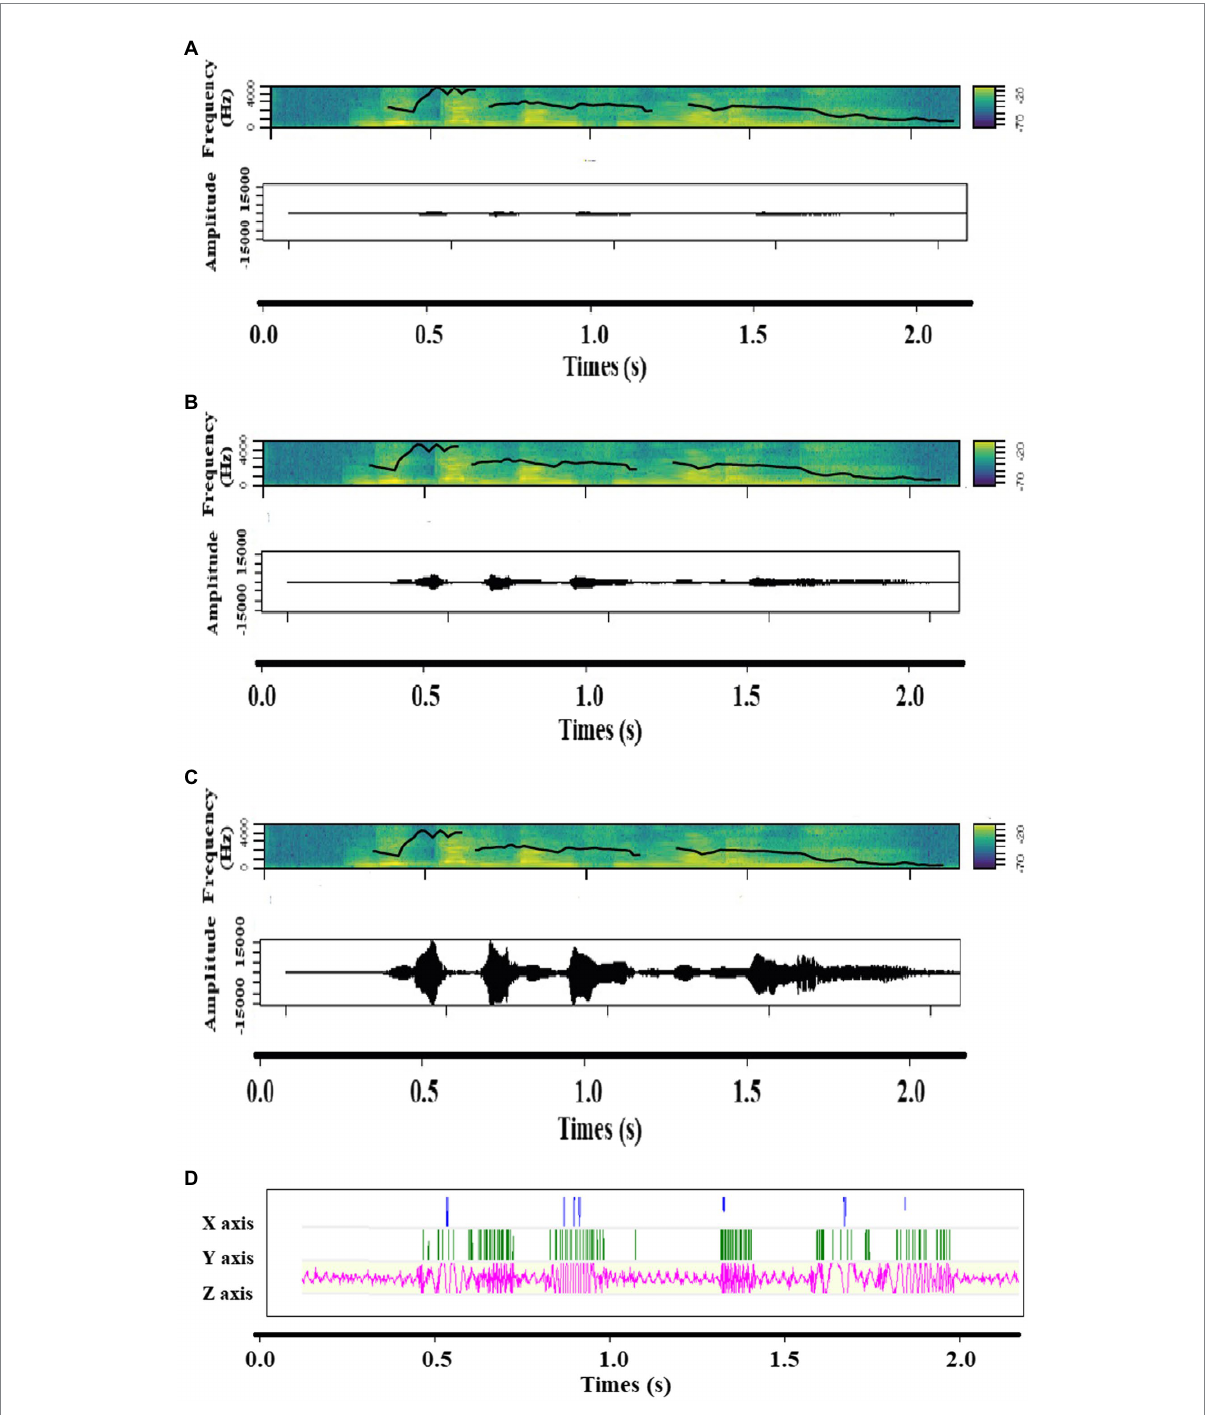
FIGURE 2 Spectrograms including contour of fundamental frequency and Amplitude time series of (A) Low intensity, (B) Medium intensity and (C) High intensity, as well as (D) the accelerometer signal of the vibration of a sound expressing